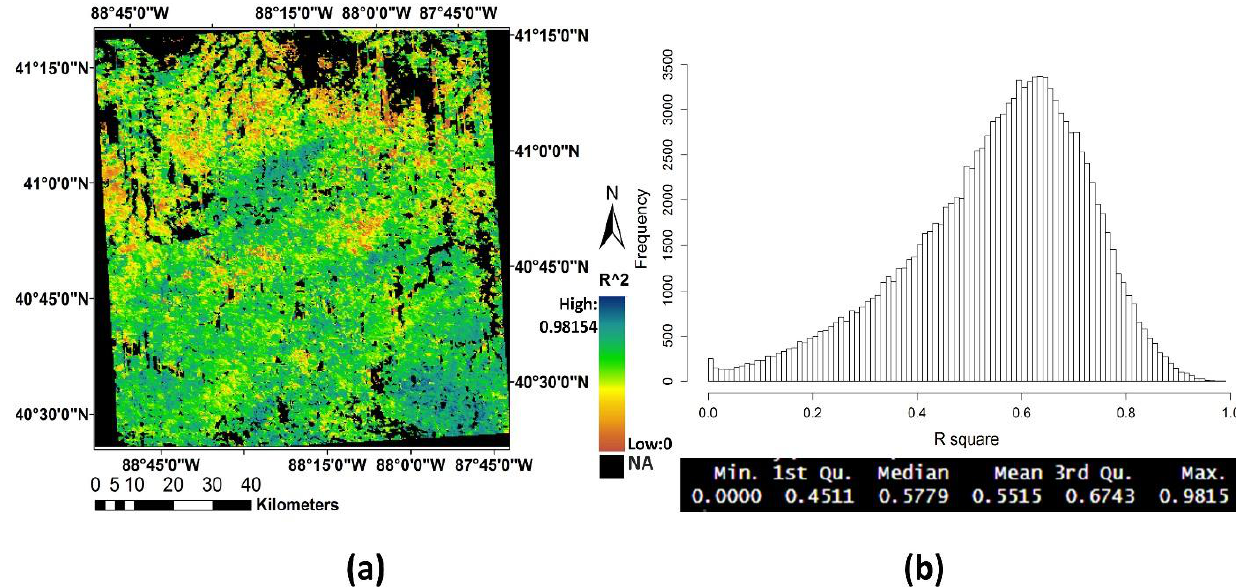
Figure 6. Coefficient of determination (R 2 ) of linear regression model to describe relationship between 𝑙𝑛(𝑏𝑎𝑛𝑑 7) and 𝐶𝐸𝑇 00.5 for each location in study area. ( a ) Spatial distribution of R 2 ; ( b ) Histogram of R 2 and statistical